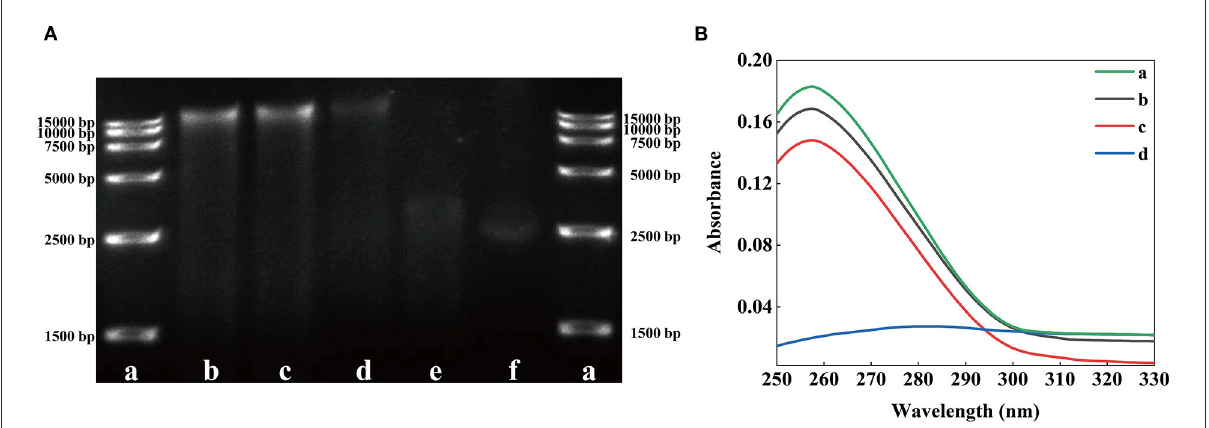
FIGURE6 Effects of solutions with different SSPE concentrations on the genomic DNA of E. coli . (A) Gel electrophoretic band analysis, a: DNA Marker, b: 0 mg/mL, c: 0.05 mg/mL, d: 0.5 mg/mL, e: 1 mg/mL, f: 5 mg/mL. (B) UV spectrum of interaction between solutions with different SSPE concentrations and E. coli genomic DNA. a: 0 mg/mL, b: 0.05 mg/mL, c: 0.1 mg/mL, d: 1